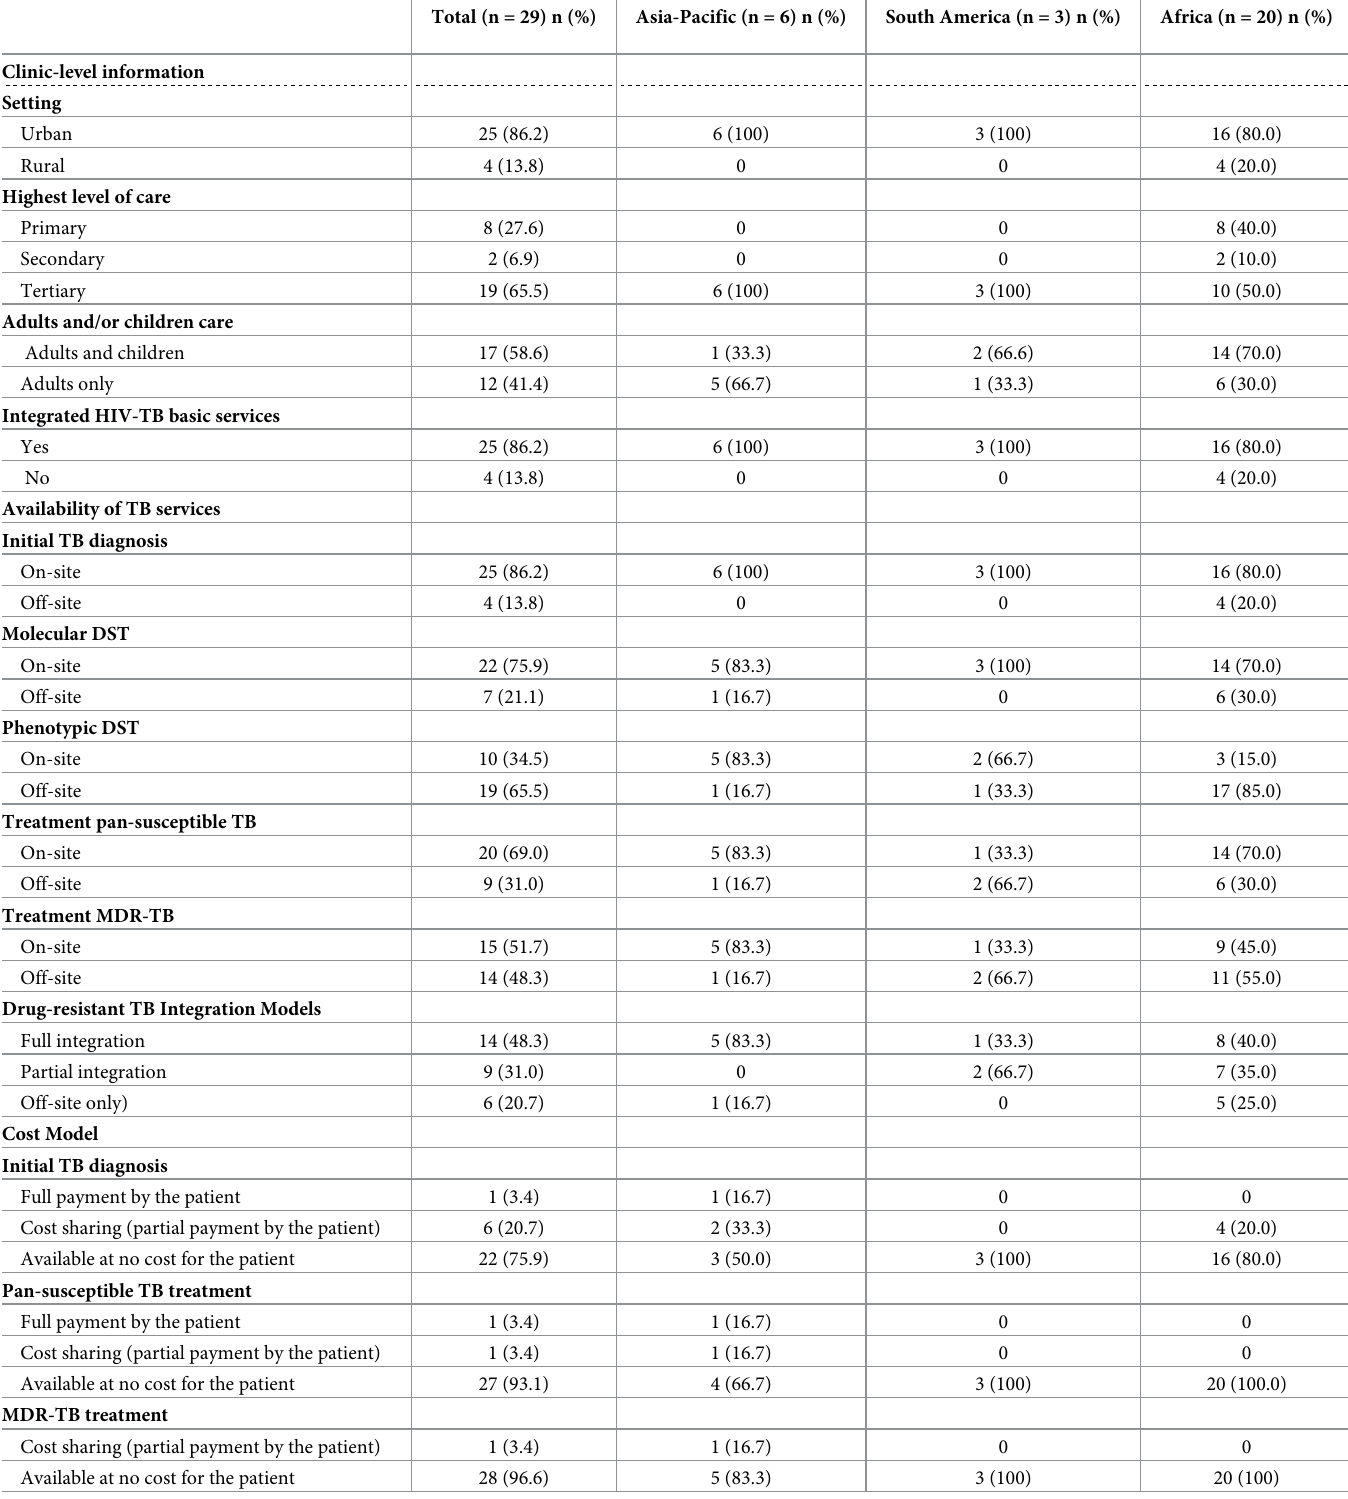
Table 1. General clinic-level information, availability of TB services and cost model of care in the 29 ART clinics participating in the study, by